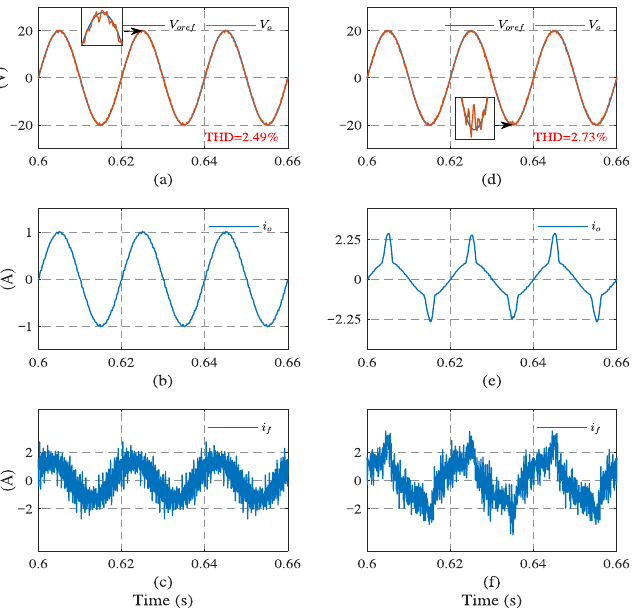
Figure 5. System simulation results with load current sensor. Under linear load: ( a ) output voltage, ( b ) load current, and ( c ) filter current. Under nonlinear load: ( d ) output voltage, ( e ) load current, and ( f ) filter